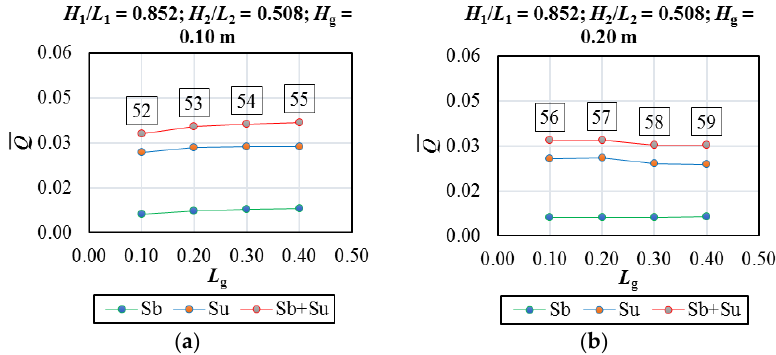
Figure 24. Behavior of Q ̅ × L g for: ( a ) cases 51, 53, 54 and 55 and ( b ) 56, 57, 58 and 59.